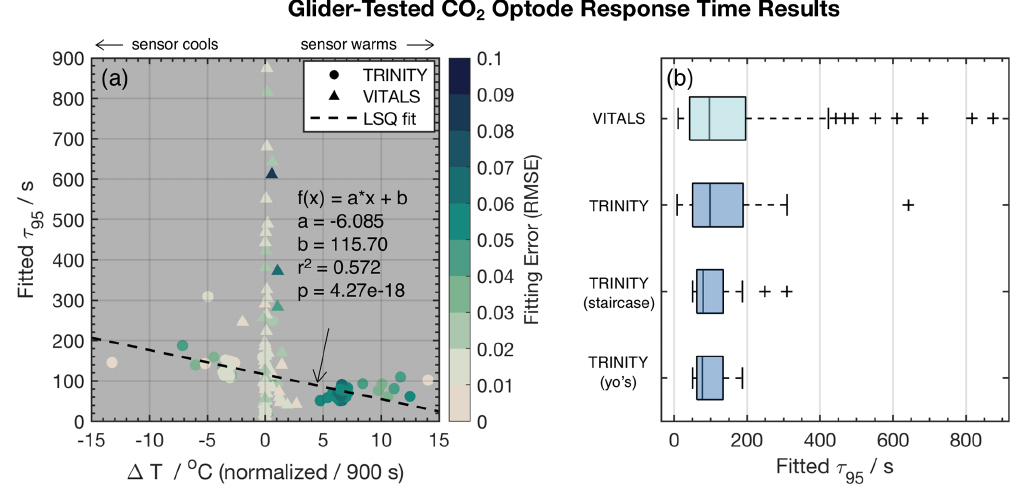
Figure 4. Panel (a) shows the CO 2 optode τ 95 values vs. temperature gradients (cid:49)T normalized by d t = 900s and color-coded for the root mean square error (RMSE) of fits to the exponential model x(t) = (a − b) exp ( − d t/τ) + b . Distinct markers are used to differentiate between the VITALS and the Trinity glider data. The dashed line indicates a linear least-squares (LSQ) fit. Panel (b) shows box plots of the fitted CO 2 optode τ 95 values from VITALS and Trinity Bay deployments. The Trinity data are divided into staircase profiles and regular